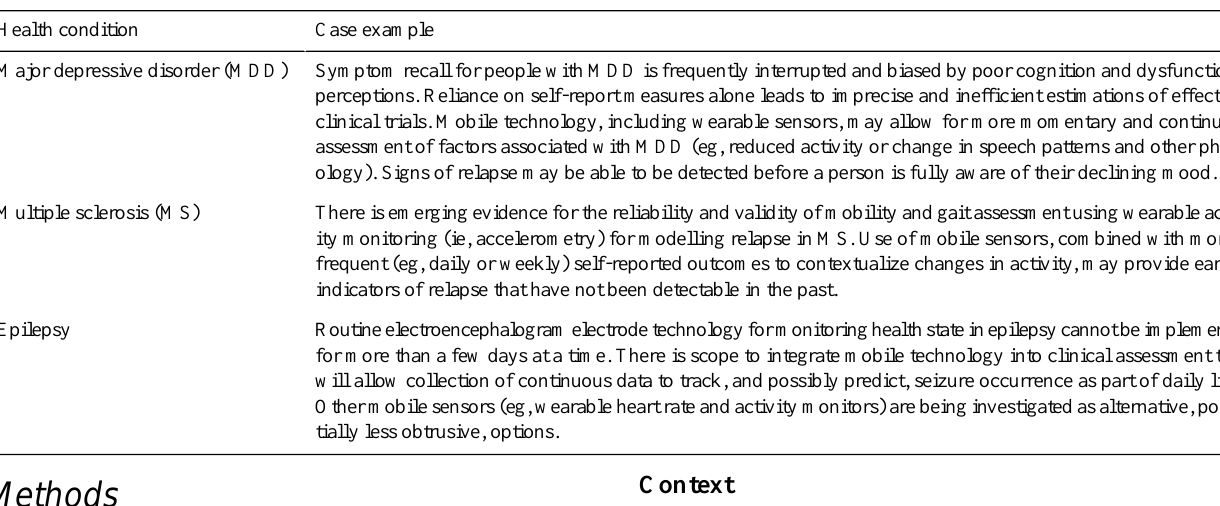
Table 1. Case examples of the use of remote measurement